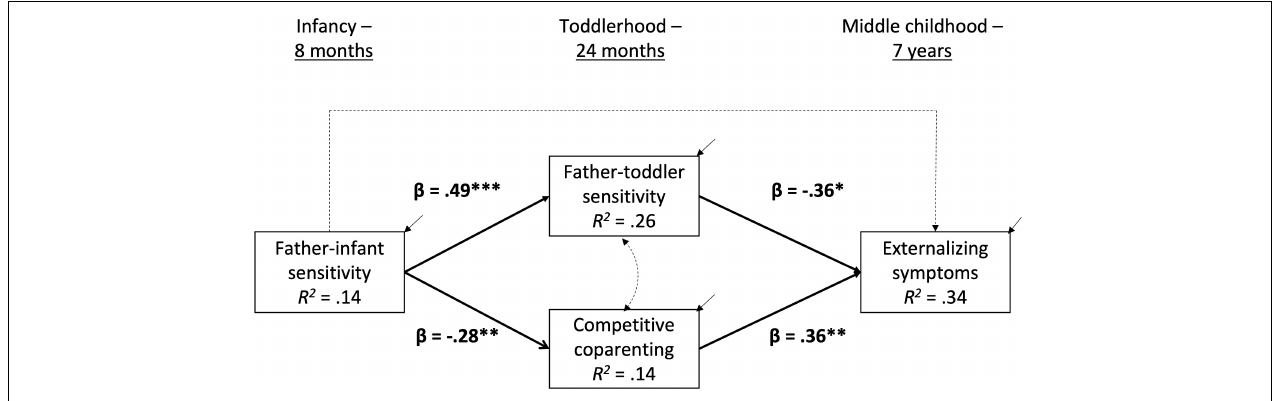
FIGURE 1 | Structural model of father sensitivity, coparenting, and child externalizing